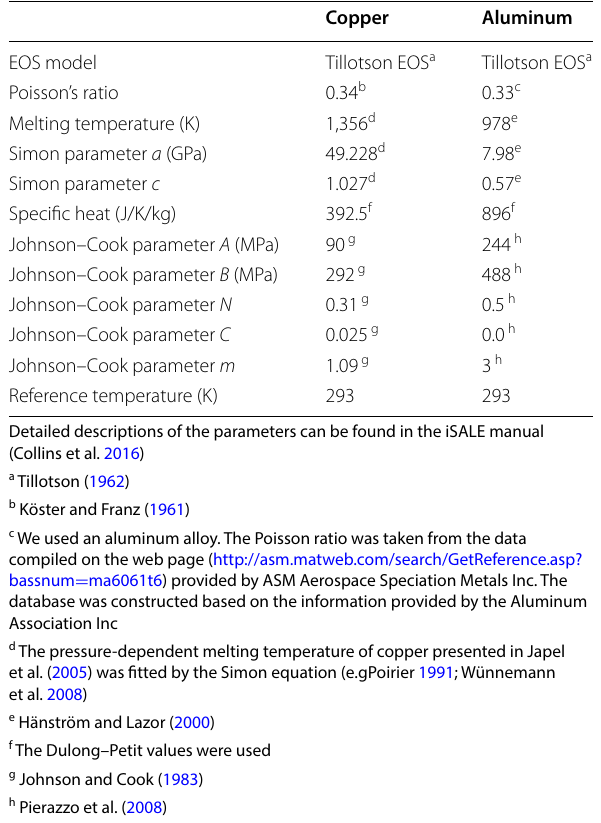
Table 2 Input parameters of the material models for the